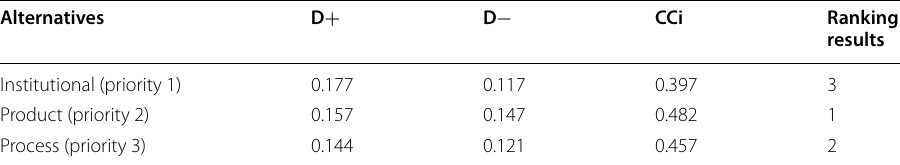
Table 11 Analysis results for the phase 4 of